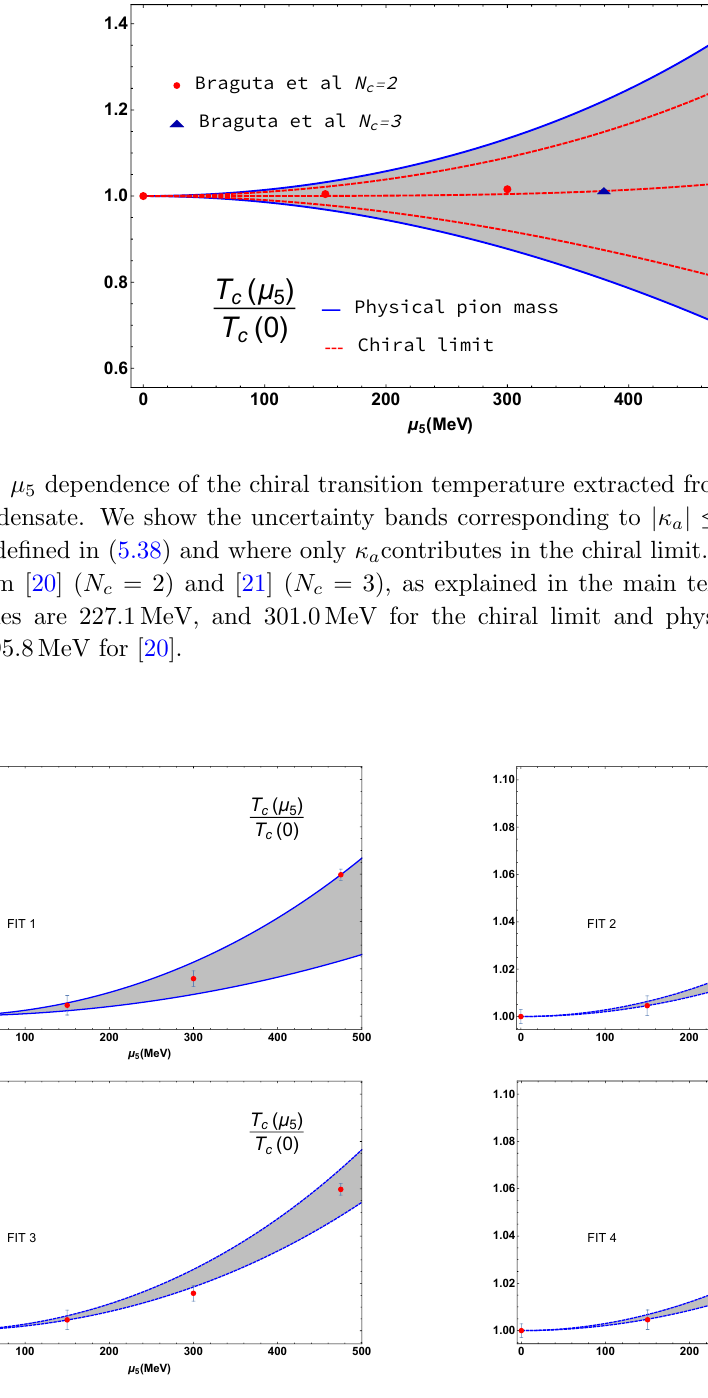
Figure 4 . Fits of T c ( (cid:22) 5 ) =T c (0) from the ChPT framework. The lattice points used for the (cid:12)t are those for N c = 2 in [20] while those for N c = 3 in [21] are showed for reference. The T c (0) values are the same as in (cid:12)gure 3.